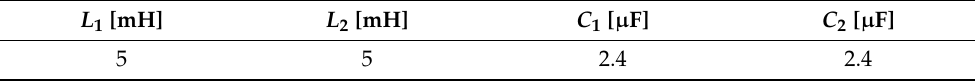
Table 2. Converter components.